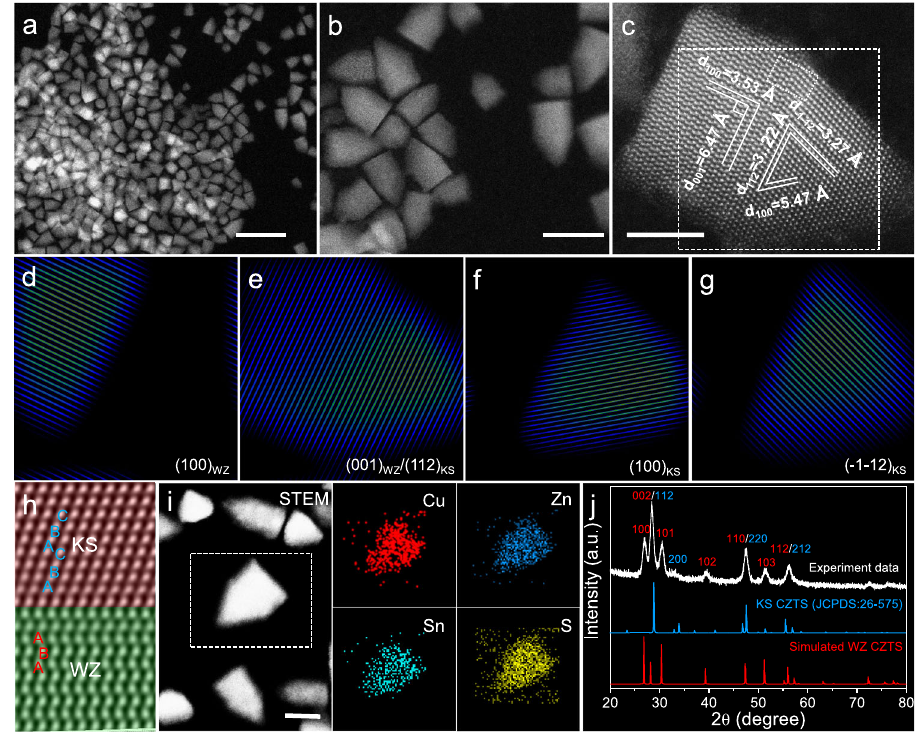
Fig. 1 | Characterization of the single-homojunction polytypic CZTS nanocrystals. Low-magni fi cationHAADF-STEM( a )andhigh-magni fi cationHAADF- STEM ( b ) images. c A representative aberration-corrected high-resolution HAADF- STEM image. Bragg- fi ltered images are derived using the (100) WZ ( d ), (001) WZ / (112) KS ( e ),(100) KS ( f )and( − 1 − 12) KS ( g )re fl ectionsbyinverseFFTinselectedareain c ,respectively. h